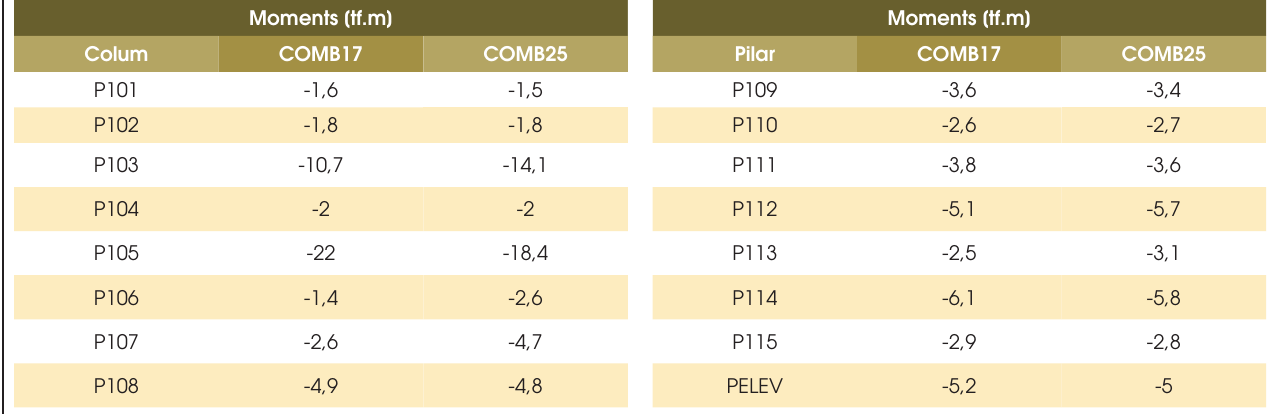
Table 12 – Moments in the region of the Coluns Model 4 - 3ª Analysis Moments [tf.m]